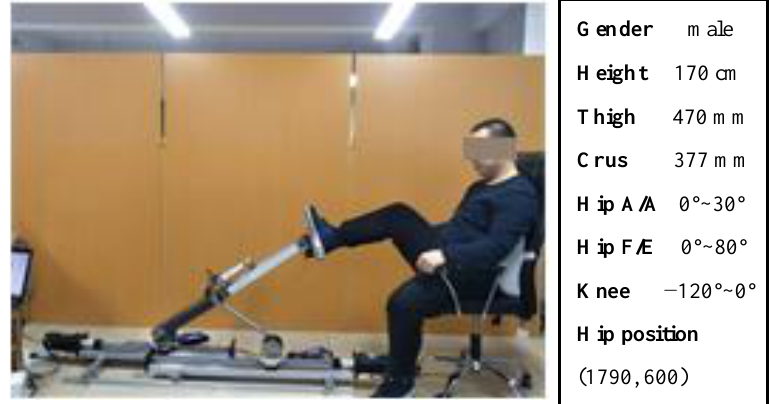
Figure 13. Prototype of the robot and relative experiment parameters.